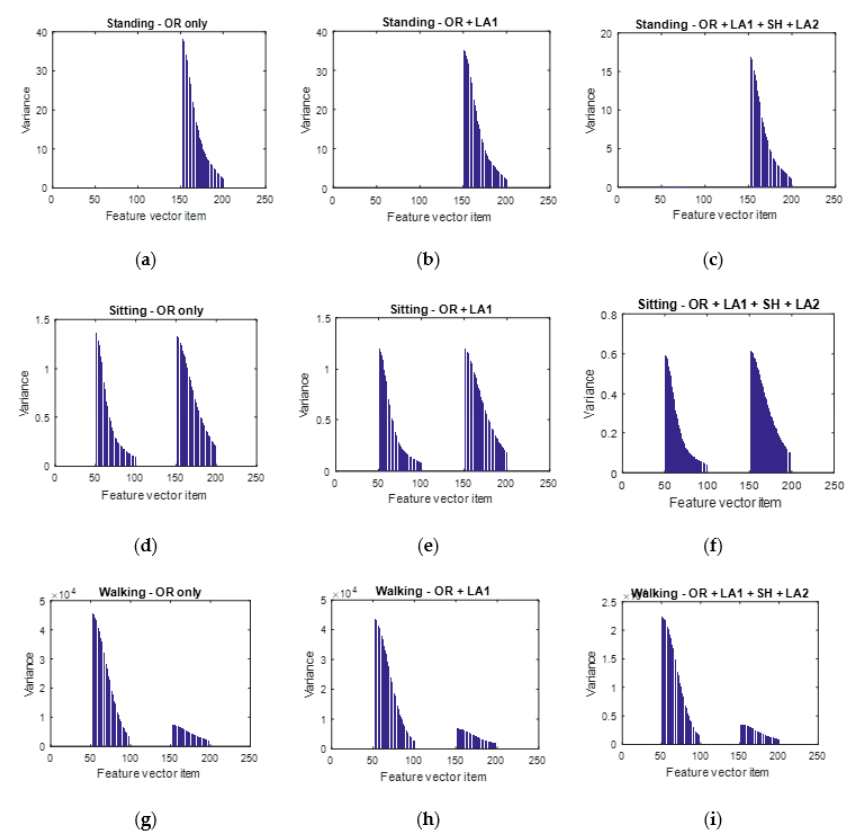
Figure 12. Visualizing the variance of data to check the influence of each data augmentation block. ( a , b , c ) represent the variance of the unaugmented dataset, augmented dataset after the first local averaging and that of the augmented dataset after the first local averaging, shuffling and the second local averaging procedure respectively for the standing activity. ( d , e ,( f ) represent the variance of the unaugmented dataset, augmented dataset after the first local averaging and that of the augmented dataset after the first local averaging, shuffling and the second local averaging procedure respectively for the sitting activity. ( g , h , i ) represent the variance of the unaugmented dataset, augmented dataset after the first local averaging and that of the augmented dataset after the first local averaging, shuffling and the second local averaging procedure respectively for the walking